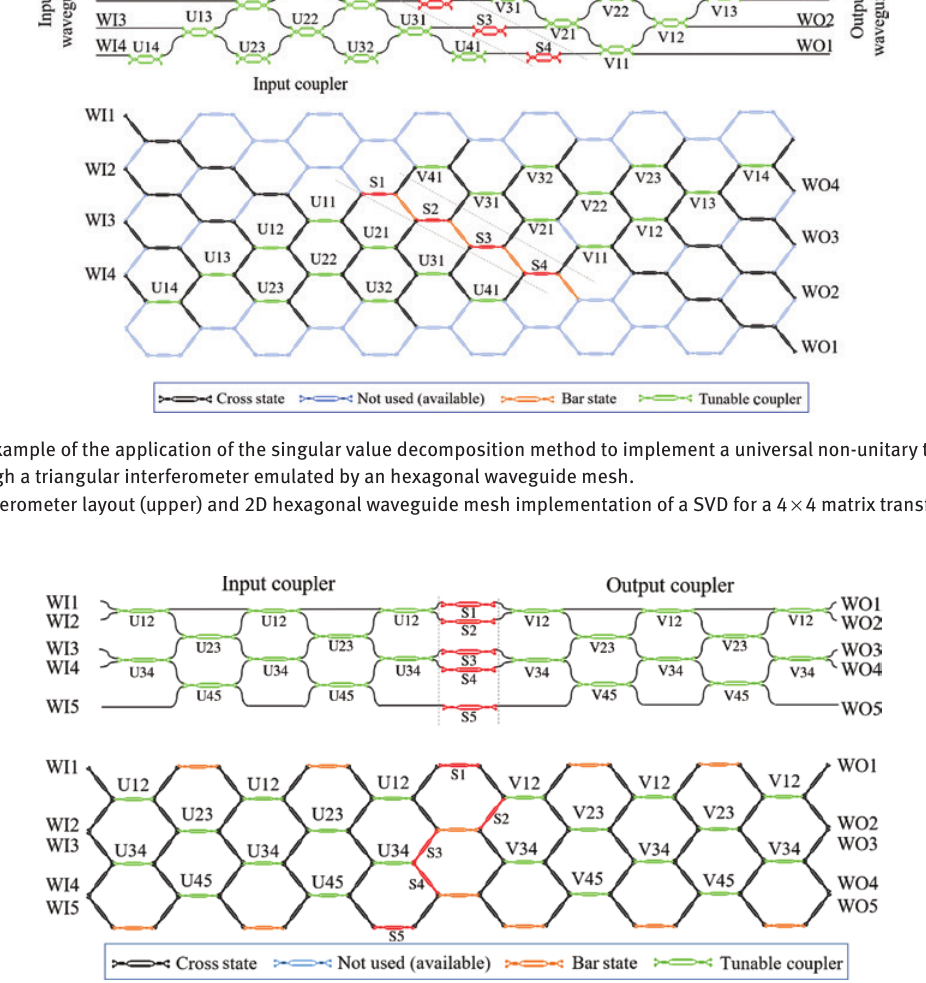
Figure 18: An example of the application of the singular value decomposition method to implement a universal non-unitary transformation emulated thorugh a rectangular interferometer emulated by an hexagonal waveguide